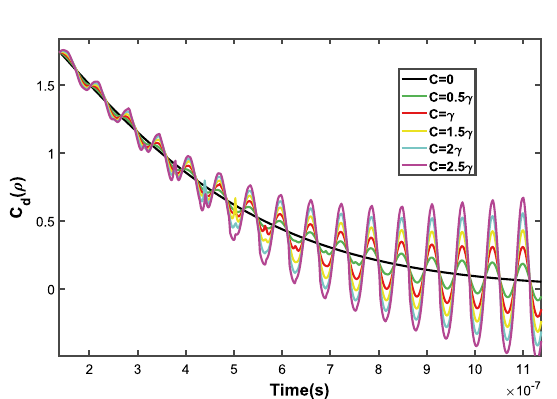
1 , γ 1 in a 1 10 8 s 5 10 6 s − − = × = ×